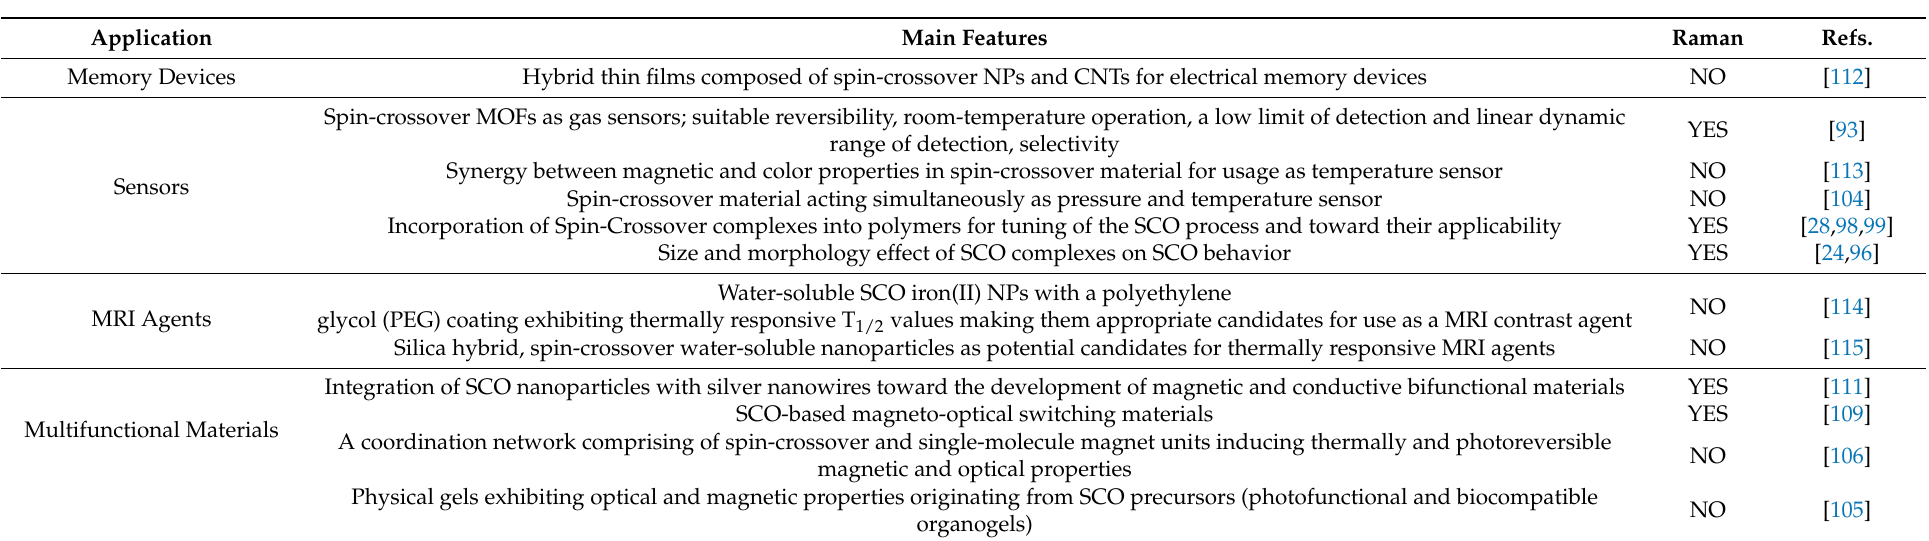
Table 2. Representative applications and relevant research of SCO materials and the contribution (or not) of Raman in these